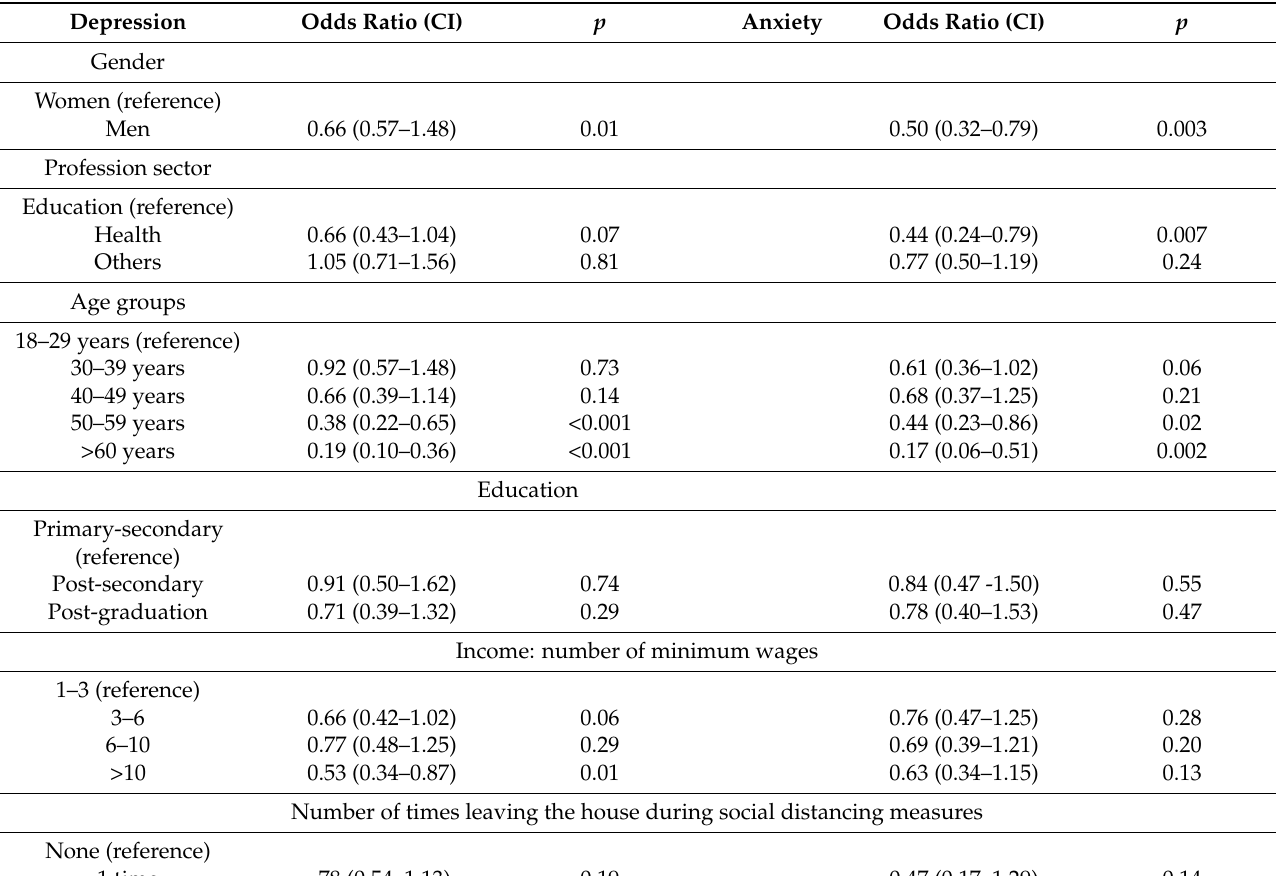
Table 3. Results of multivariate logistic regression analyses, adjusted for socioeconomic variables and social distancing, on severe anxiety and depression symptoms ( n =